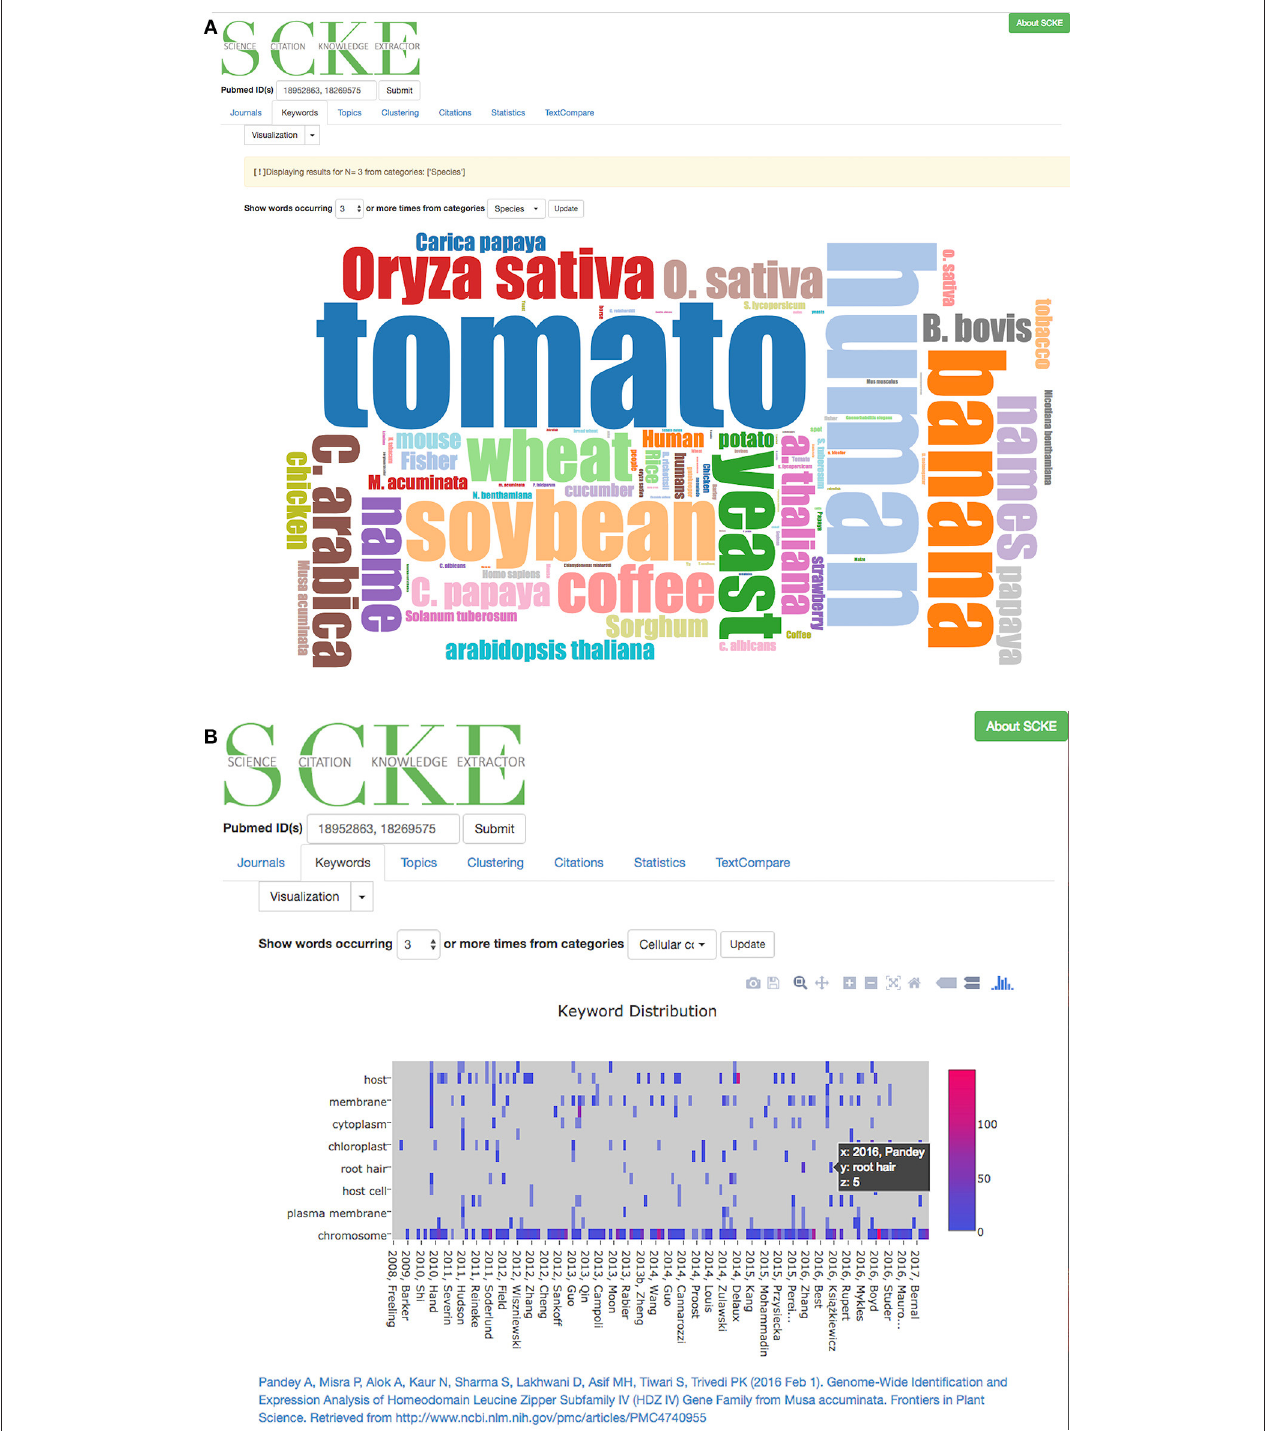
FIGURE 7 | (A) A word cloud has been generated to show all named entities classified as a species during the document annotation phase. Users can filter their word clouds to include more or fewer words by specifying that visualized words should appear at least N times. (B) An interactive heatmap that visualizes named entities across all citing documents. Users can zoom in or out of the heatmap to look closely at certain documents. By clicking on a column in the heatmap, a link to the original document is provided as well.